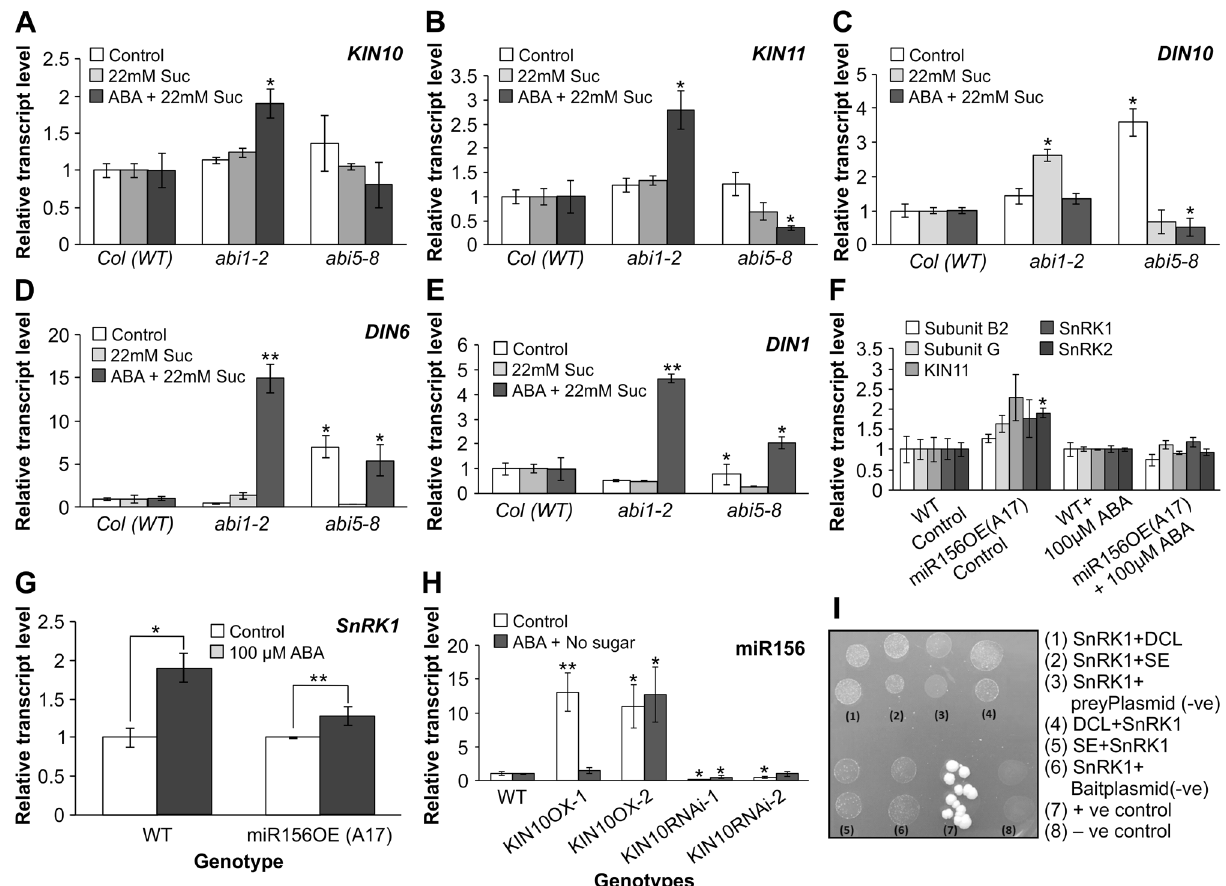
Figure 5. ABA-dependent expression of SnRK1 may regulate miR156 . SnRK1 catalytic subunits ( A ) KIN10 , ( B ) KIN11, relative transcript levels of DARK INDUCED, DIN, ( C ) DIN10 , ( D ) DIN6 , ( E ) DIN1 genes in Arabidopsis , ( F ) relative transcript levels of SnRK1 and SnRK2 along with SnRK1 regulatory and catalytic subunits in response to 100 µM ABA treatment, ( G ) transcript levels of SnRK1 upon 100 µM ABA treatment relative to their counterpart control alfalfa plants, ( H ) relative transcript levels of miR156 in KIN10 overexpressing and RNAi silenced Arabidopsis plants, ( I ) Yeast-two-hybrid (Y2H) assay for the interaction between SnRK1 and miR156 biogenesis genes. n = 50 biological replicates of Arabidopsis in ‘ A ’ to ‘ E ’ and ‘ H ’ while three alfalfa plants in ‘ F ’ and ‘ G ’. Arabidopsis specific three housekeeping genes (elongation factor- alpha, tubulin, and actin) are used for relative transcript analysis relative to WT in ‘ A ’ to ‘ E ’ and ‘ H ’ while alfalfa specific elongation factor, actin and ubiquitin10 are used in ‘ F ’ and ‘ G ’. Values are means with ± SE. In ‘ I ’, protein-coding whole sequences of the genes were amplified using gene-specific primers with the addition of ‘CACC’ in the forward primer, for directional cloning (Table S1). The interaction between the pEXP32/Krev1 (rat Krev1) with pEXP22/RalGDS-wt (ras association domain of RalGDS) is used as positive control while for the negative control pEXP32/Krev1 with the mutated ras association domain of RalGDS, pEXP22/RalGDS-m2, was used according to the user’s